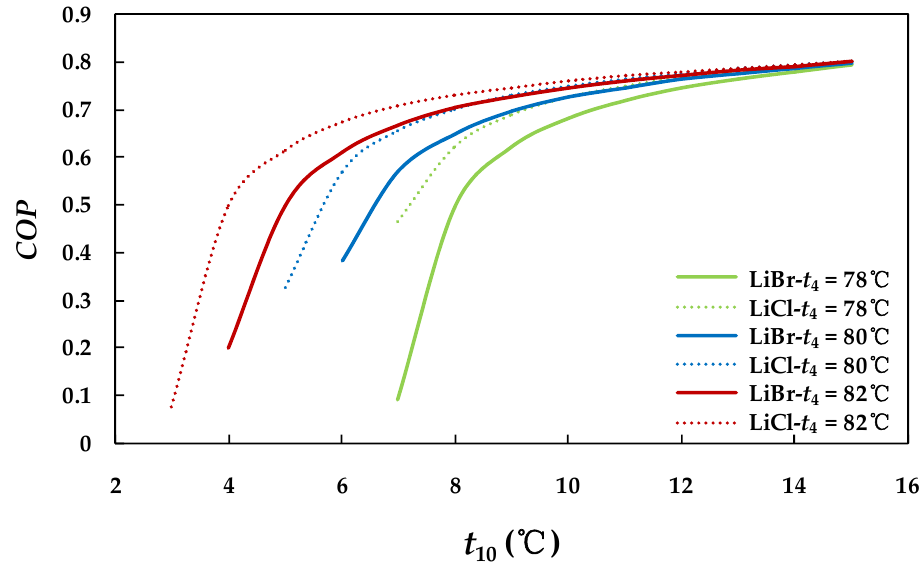
Figure 9. Evaporator temperature impact on the COP of the absorption system under various generator temperature levels (78 °C, 80 °C, and 82 °C) for the two working pairs ( t 1 = t 8 = 40 °C, ε = 0.7).